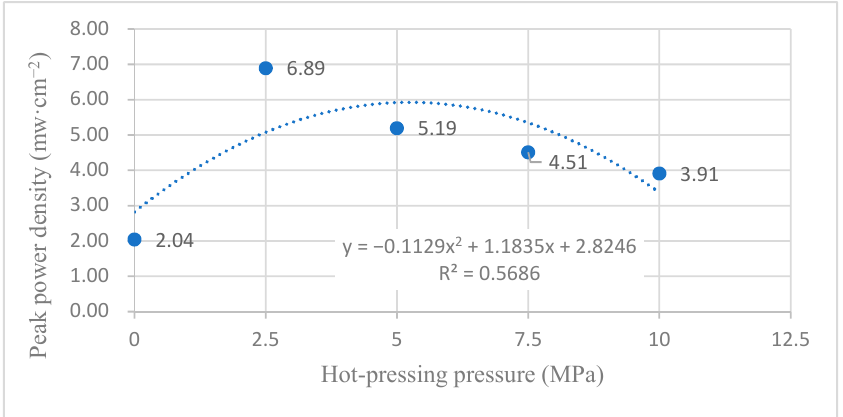
Figure 20. The fitting curve of the peak power density of MEA at different hot-pressing pressures under room temperature and oxygen conditions.